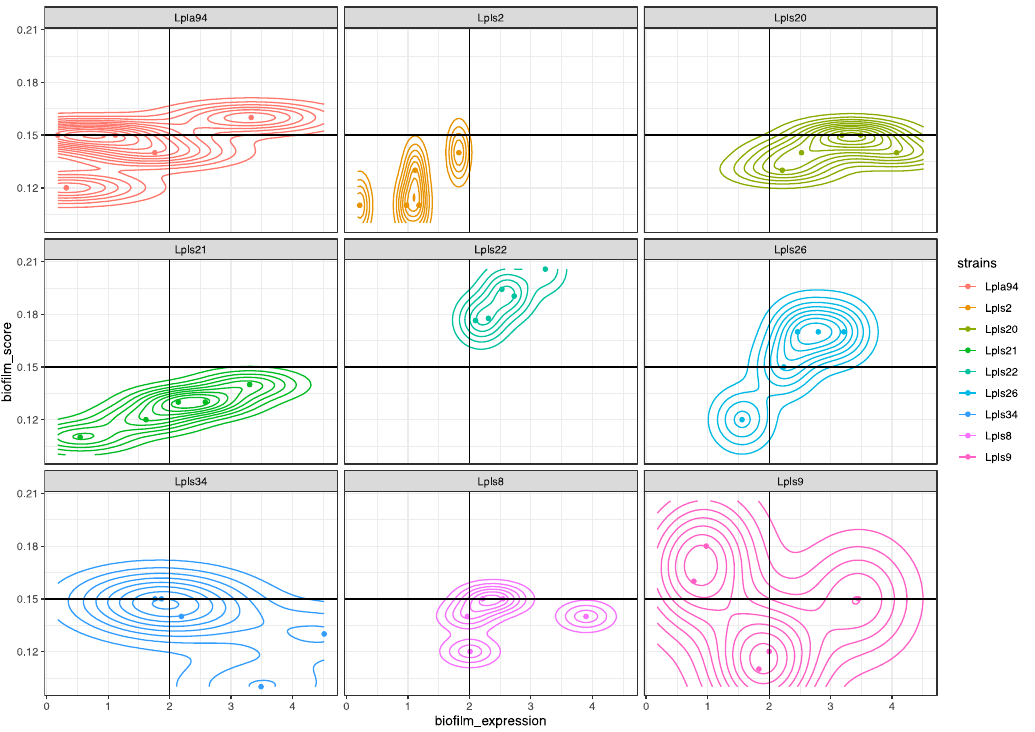
Figure 6. Density plot of biofilm_expression and biofilm_score indices of high biofilm L. plantarum producer strains.